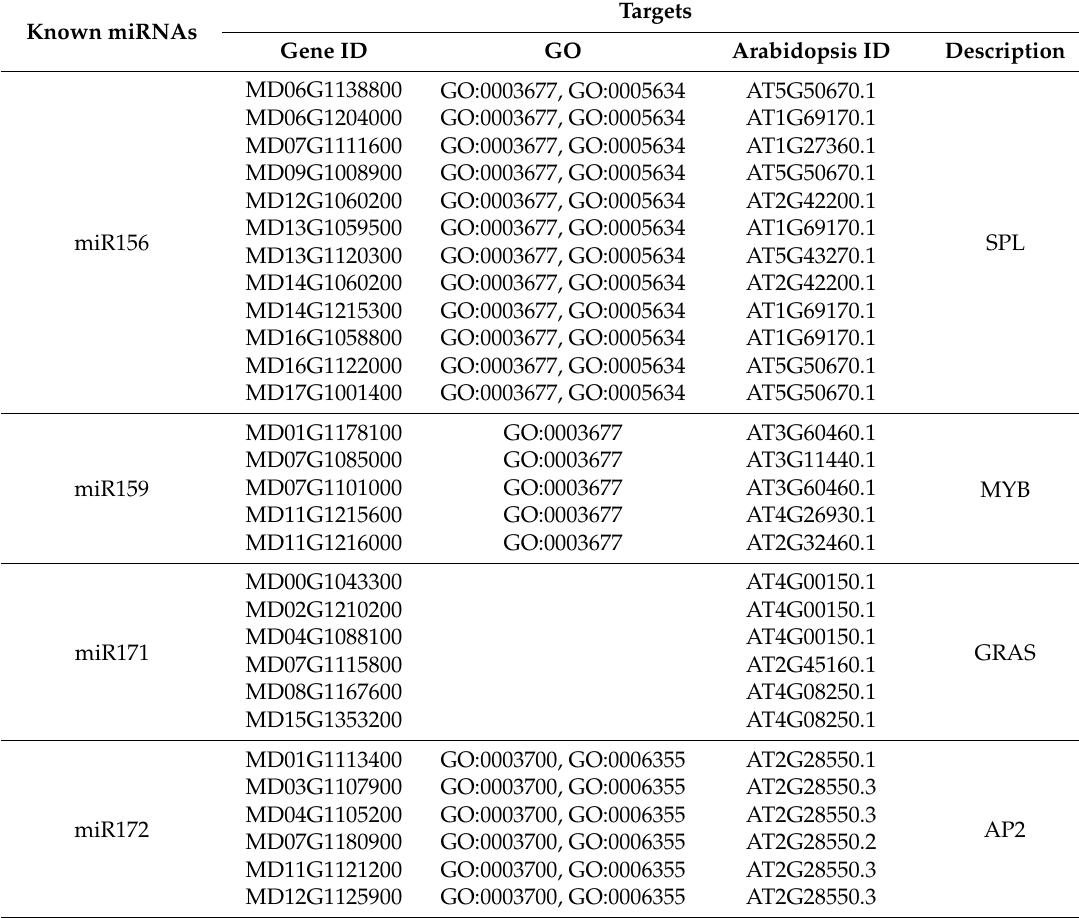
Table 3. Potential targets of identified known miRNAs in apple ( Malus domestica Borkh.) and their GO biological